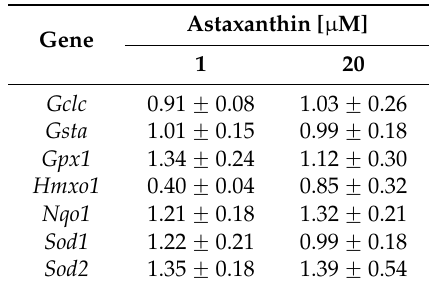
Table 1. Nrf2-target gene expression in astaxanthin treated Huh7 cells (THF control cells were set to be 1.0).